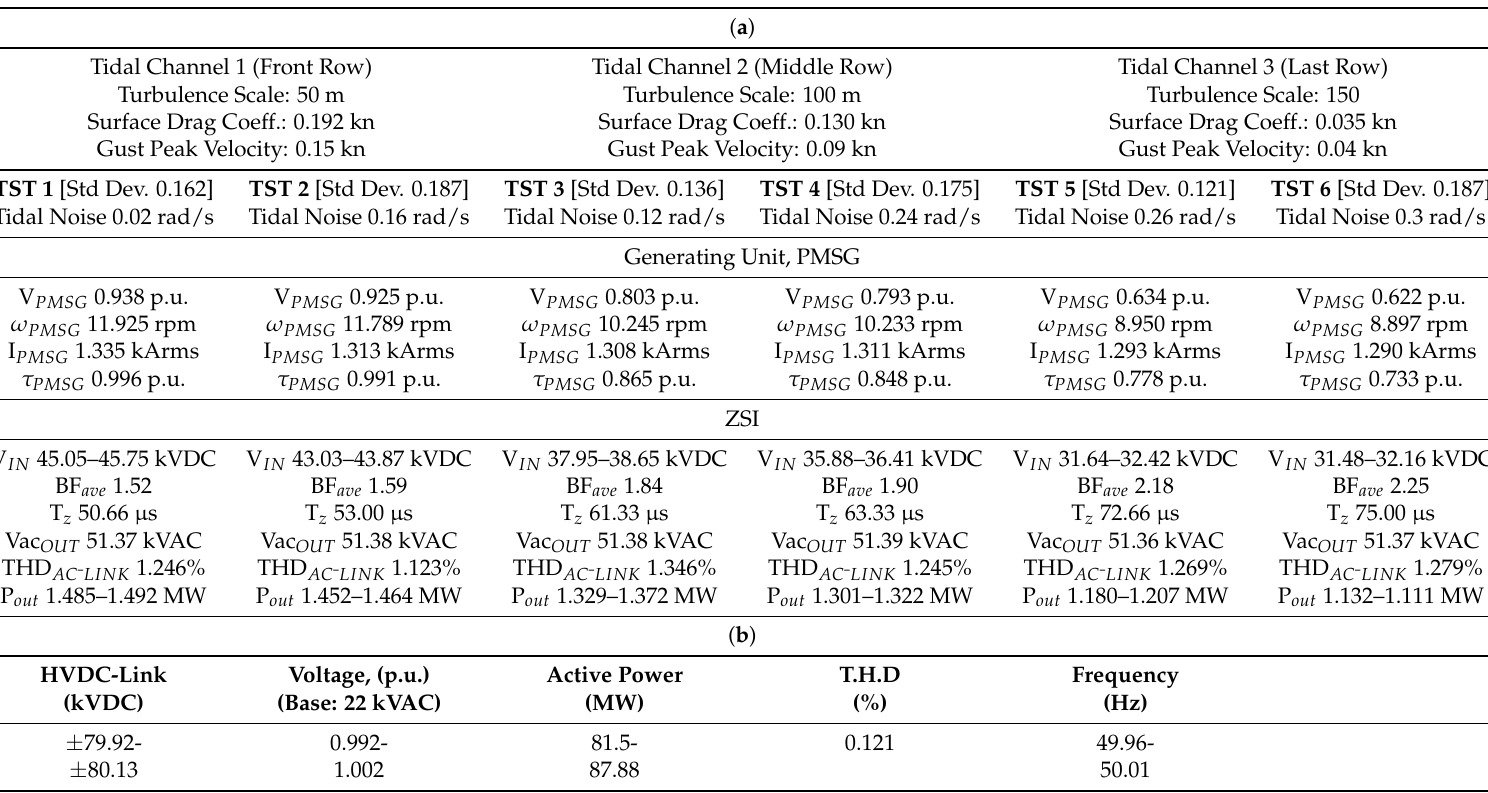
Table 5. ( a ) Performances of individual TST at respective tidal channels for cluster 1; ( b ) readings at PCC busbar and bi-pole transmission sending-end. ( a )